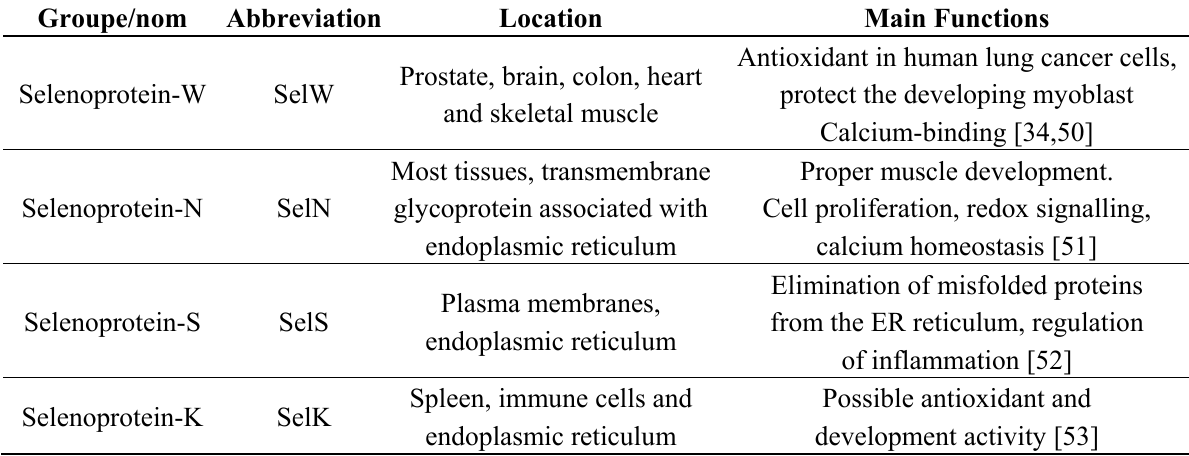
Table 3. Some human selenoproteins and their